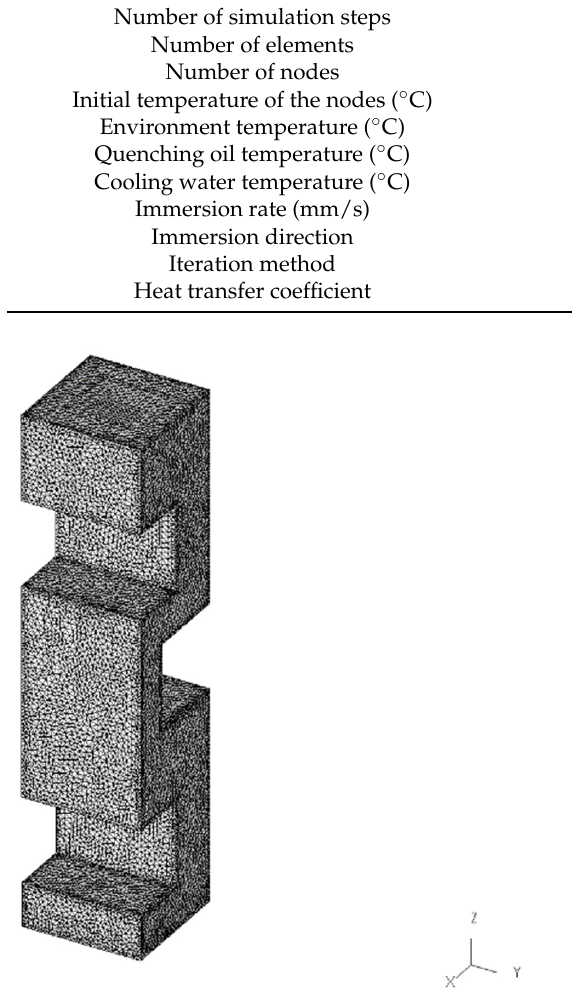
Figure 2. Mesh used in FEM simulation.